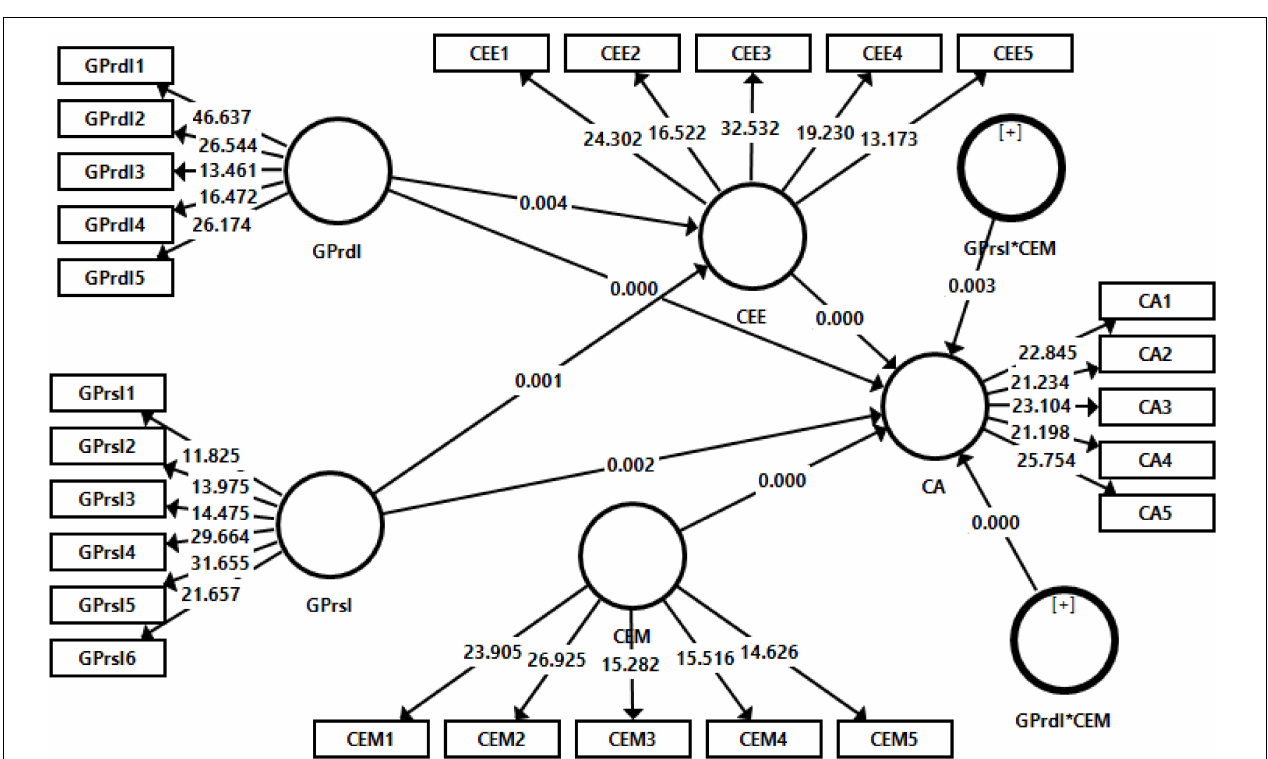
FIGURE 3 | Structural model assessment.